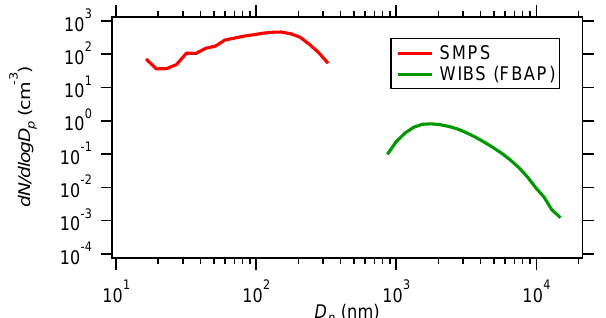
Figure 3. Combined log–log plot of total particle number size dis- tribution (as measured with the SMPS) with FBAP number size dis- tribution (from the WIBS). It should be noted that the SMPS mea- sured the mobility diameters of particles in a dried sample, while the WIBS measured optical diameters at ambient humidity.